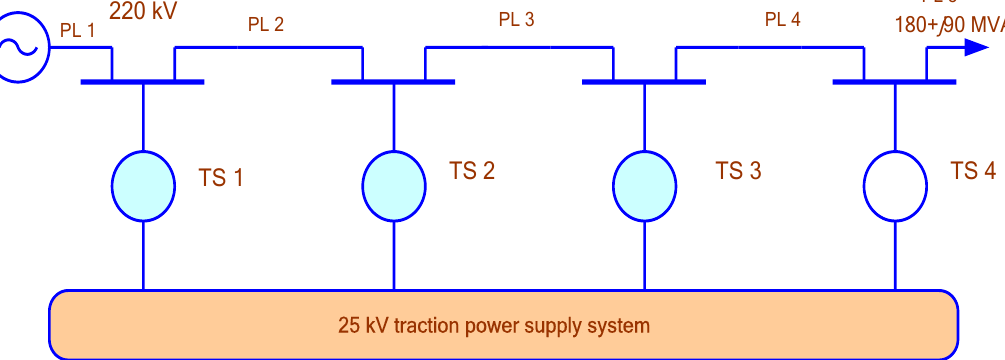
Figure 1. Network circuit: TS–traction